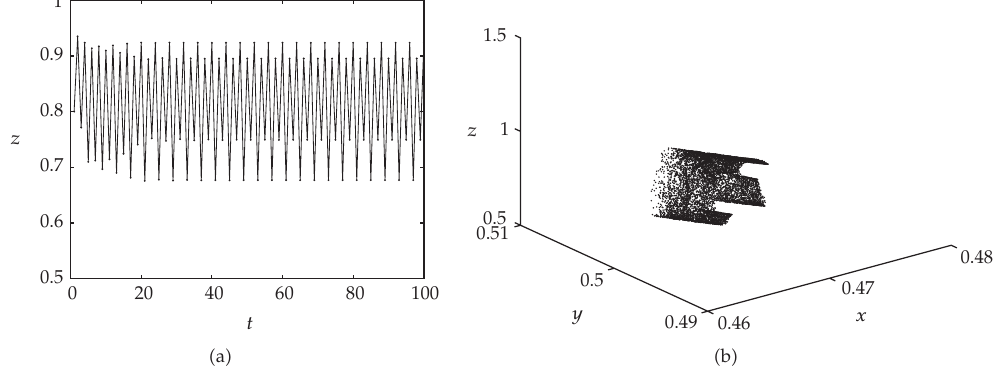
Figure 5: (cid:5) a (cid:6) The time series of the output with r (cid:7) 0 . 40, α (cid:7) 0 . 63, and η (cid:7) 0 . 50; (cid:5) b (cid:6) the chaotic attractor of the controlled system with r (cid:7) 0 . 40, α (cid:7) 0 . 63, and η (cid:7) 0 .